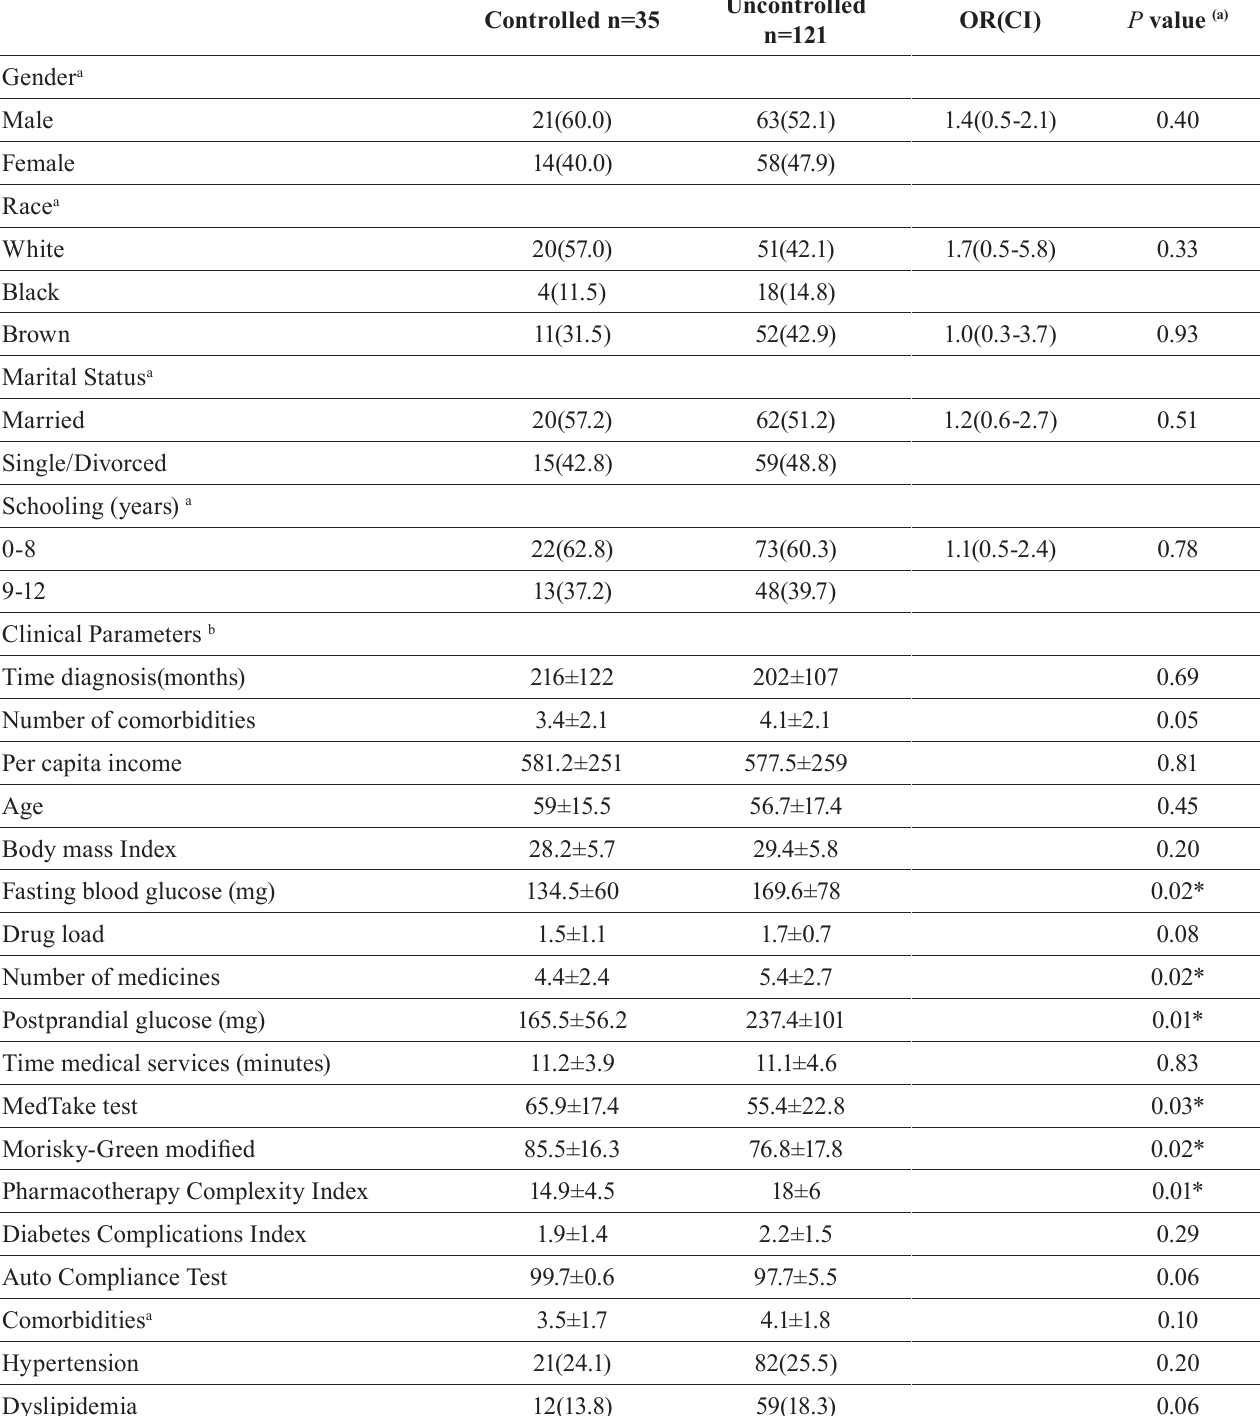
TABLE I - B aseline demographic and clinical characteristics of T1DM patients